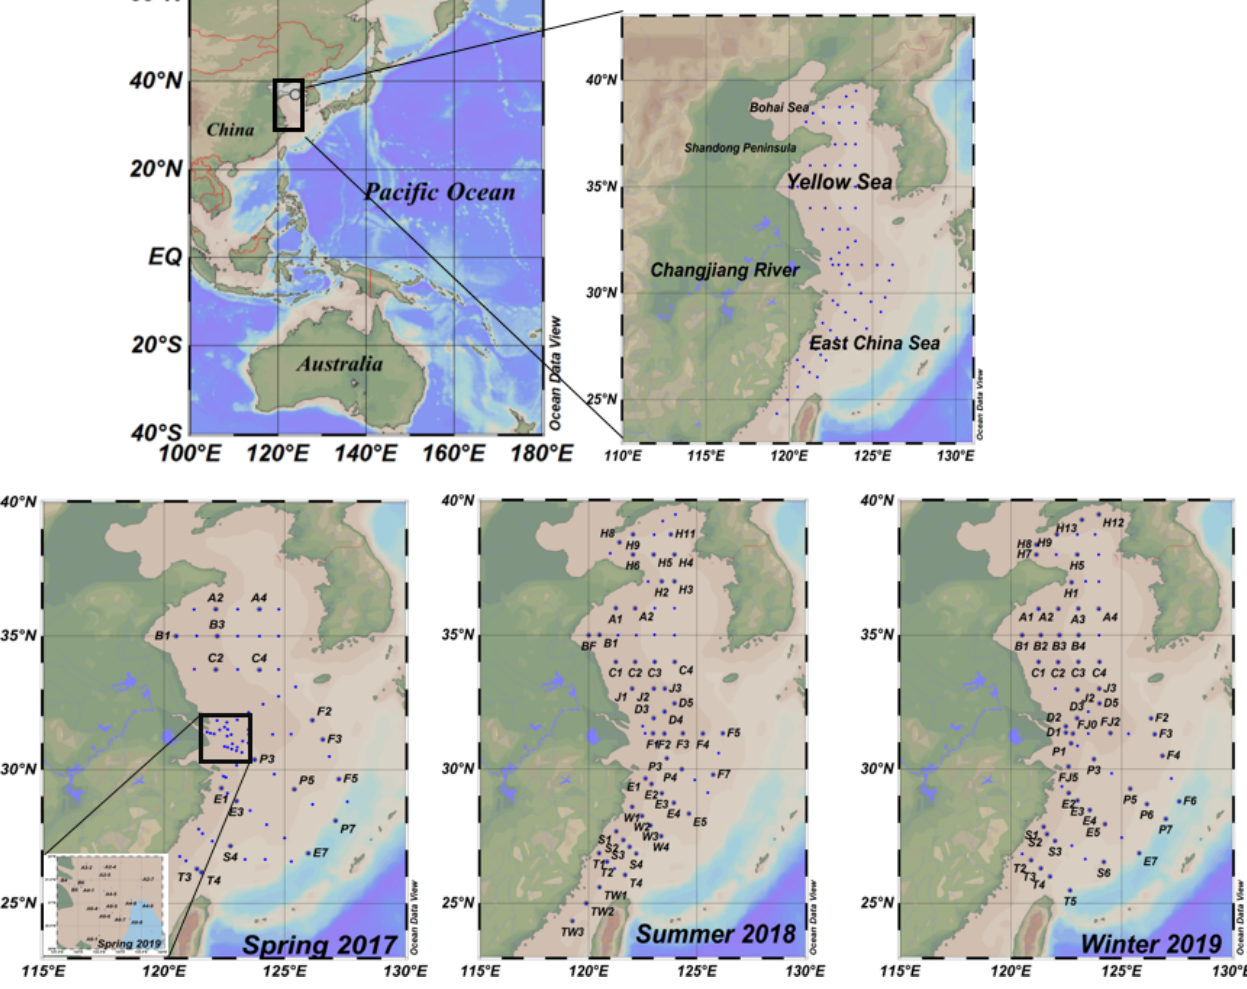
Figure 1. Map of sampling